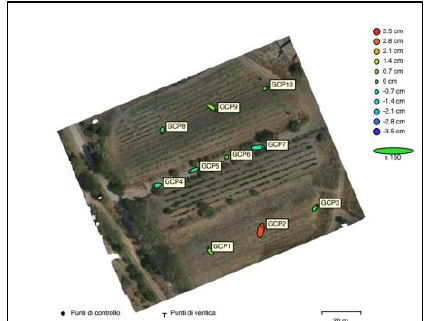
Figure 6. r.m.s. GCPs – 30 m flight